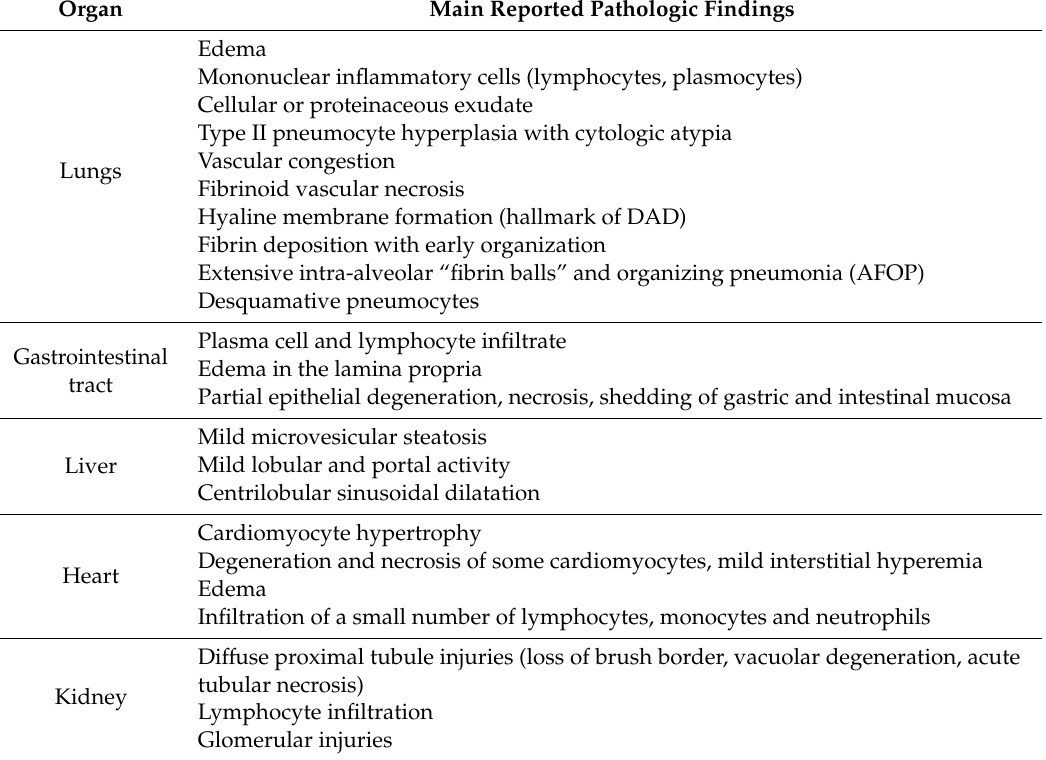
Table 1. Main pathologic findings in the context of SARS-CoV-2 infection reported in the literature. DAD: di ff use alveolar damage and AFOP: acute fibrinous and organizing